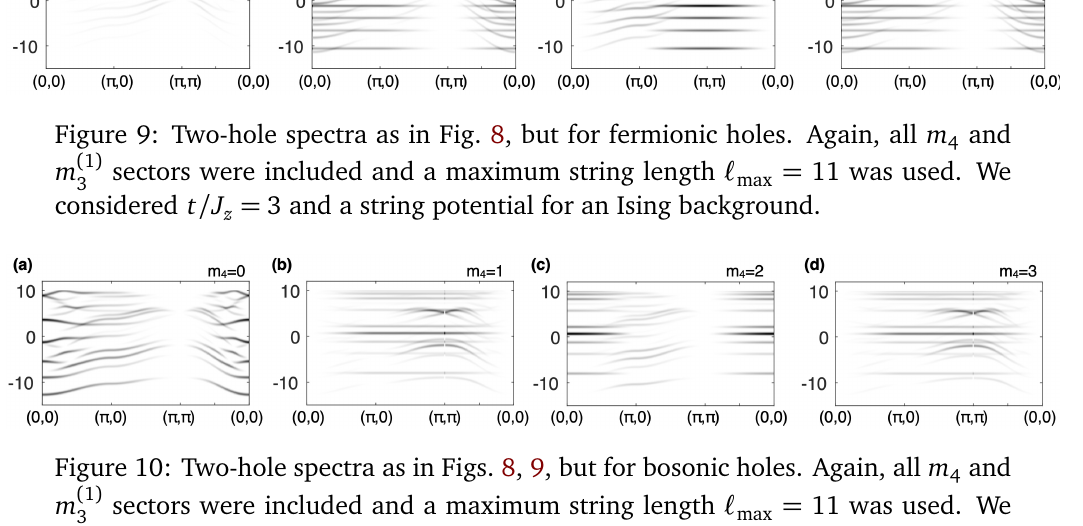
Figure 10: Two-hole spectra as in Figs. 8, 9, but for bosonic holes. Again, all m ( 1 ) m sectors were included and a maximum string length ℓ 3 = 3 and a string potential for an Ising considered t / J z